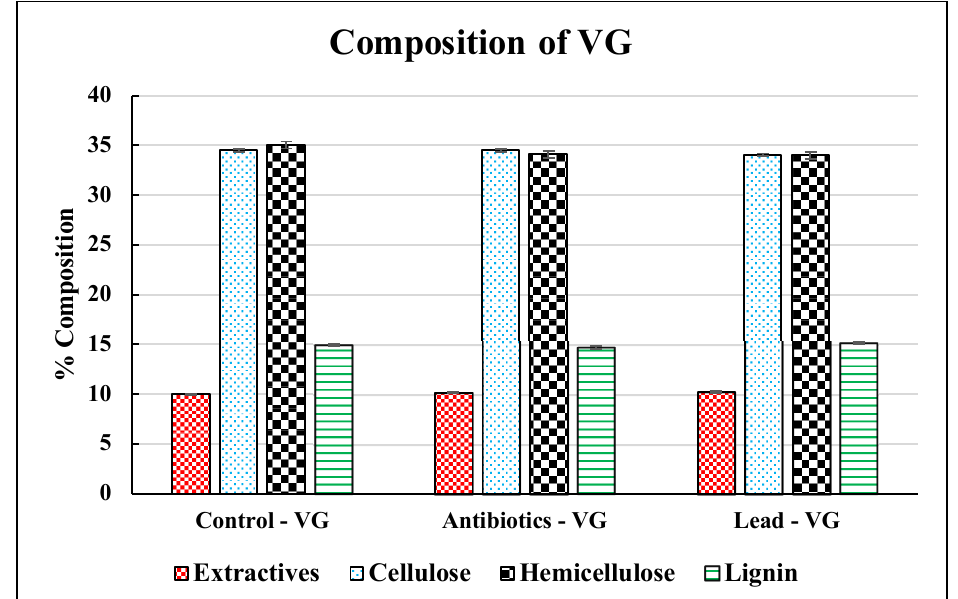
Figure 2. Lignocellulosic composition of VG from different sources. Table 1. Comparison of the main composition of VG and other C4 grasses from previous